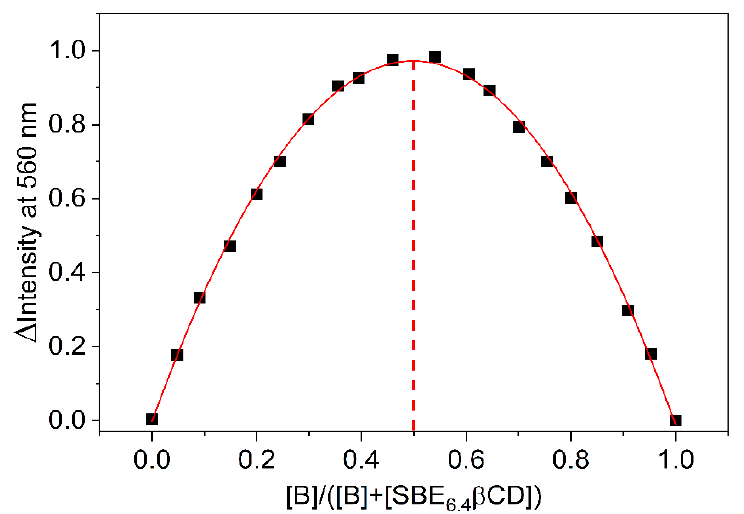
Figure 3. Job plot of the fluorescence intensity change at 560 nm as a function of the mole fraction of B ( ▪ ). The line displays the fitted second-order polynomial. The sum of SBE 6.4 β CD and B total concentrations is held constant (4.6 µ M). Dash line shows 0.5 mole fraction.